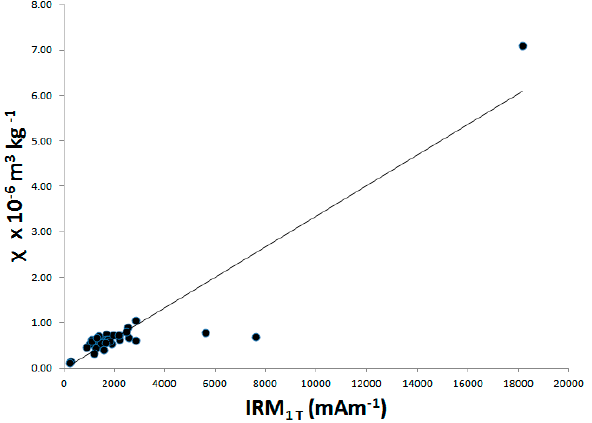
Fig. 6. Correlation between magnetic susceptibility and IRM 1T .